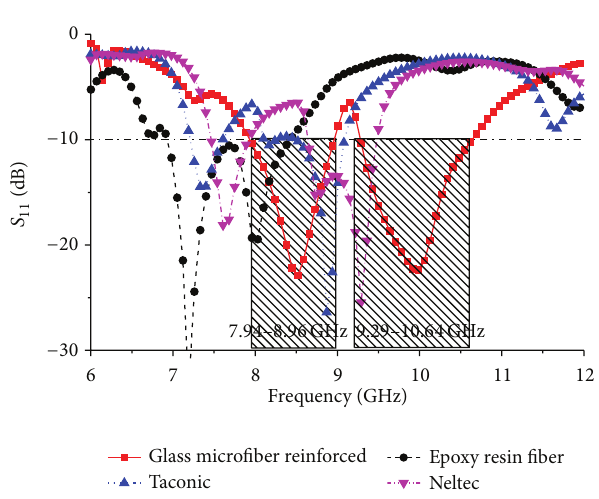
Figure 3: Reflection coefficient of the antenna for different substrate